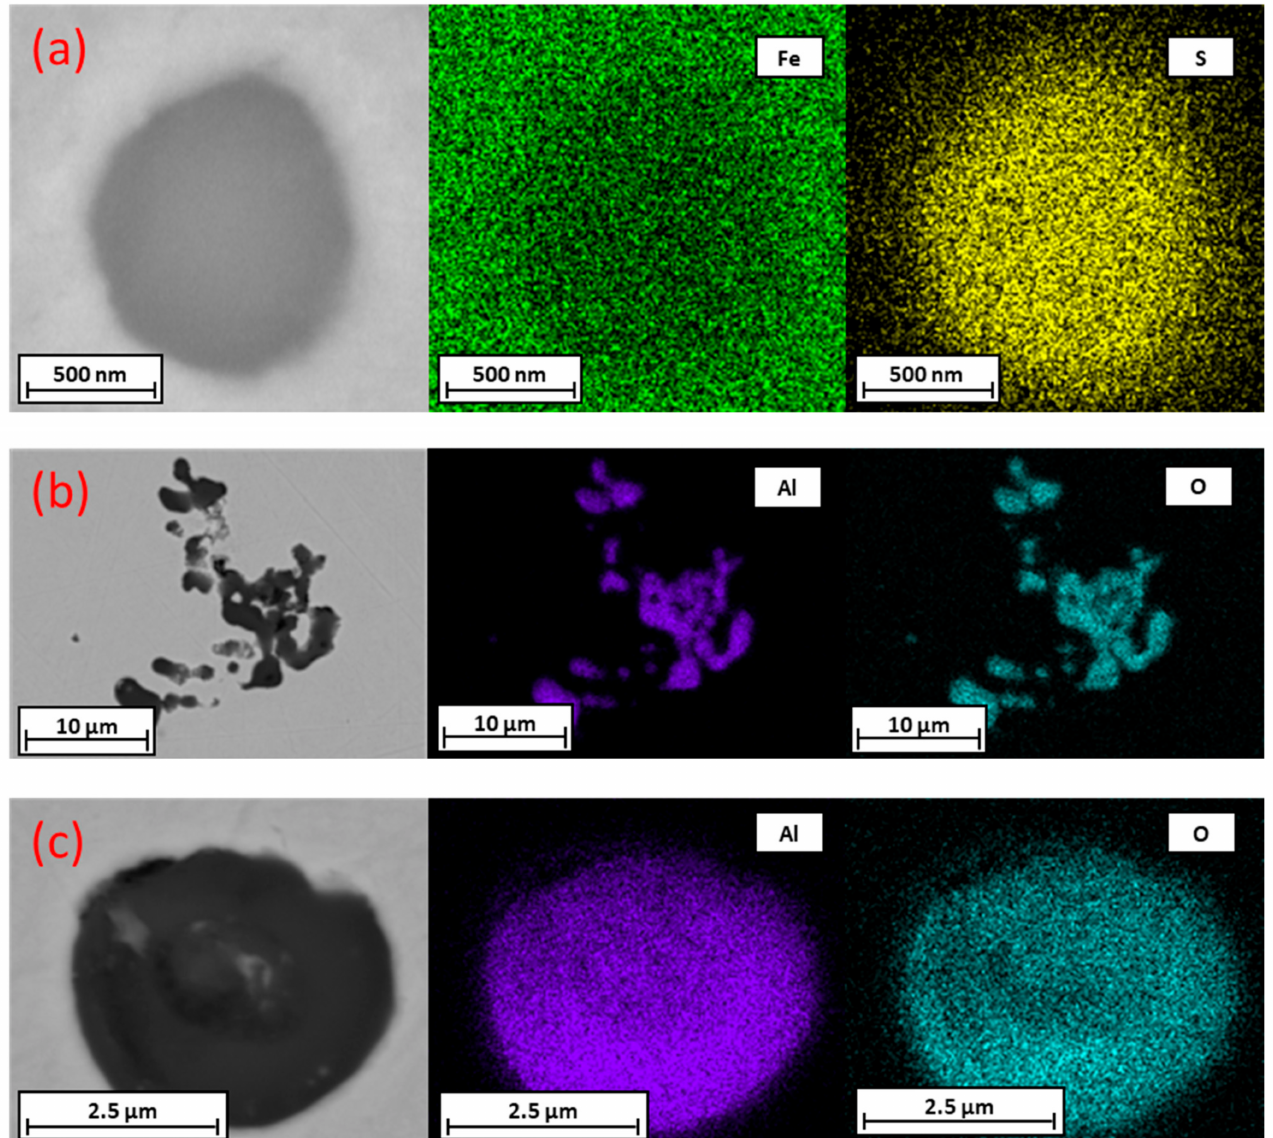
Figure 1. Backscattered electron (BSE) image and elemental mapping of inclusions: ( a ) iron sulfide; ( b ) alumina cluster; ( c ) single alumina